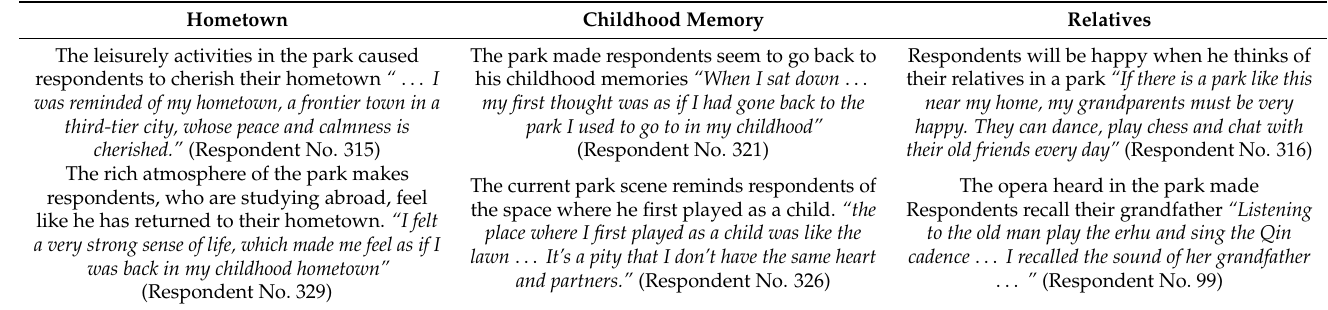
Table 7. Young adults’ place attachment to urban parks.